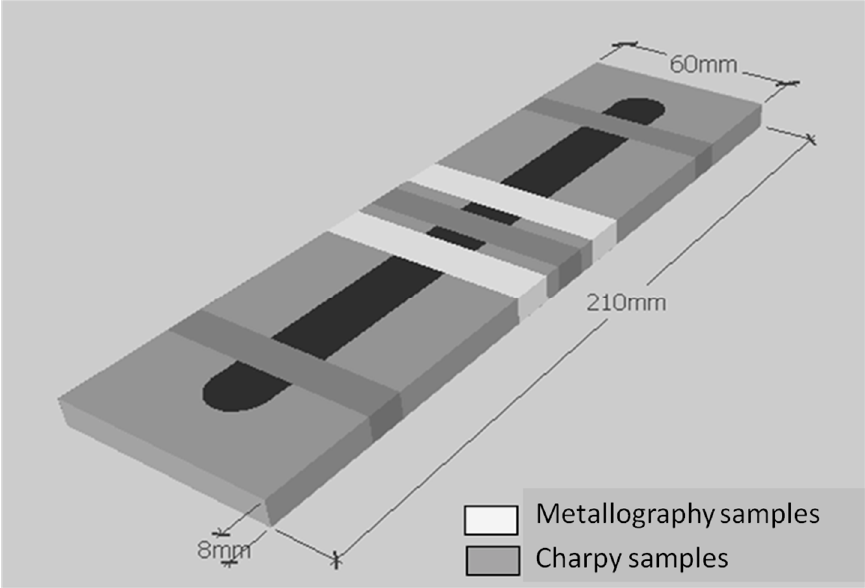
Figure 1. Schematic drawing showing sample cuts.